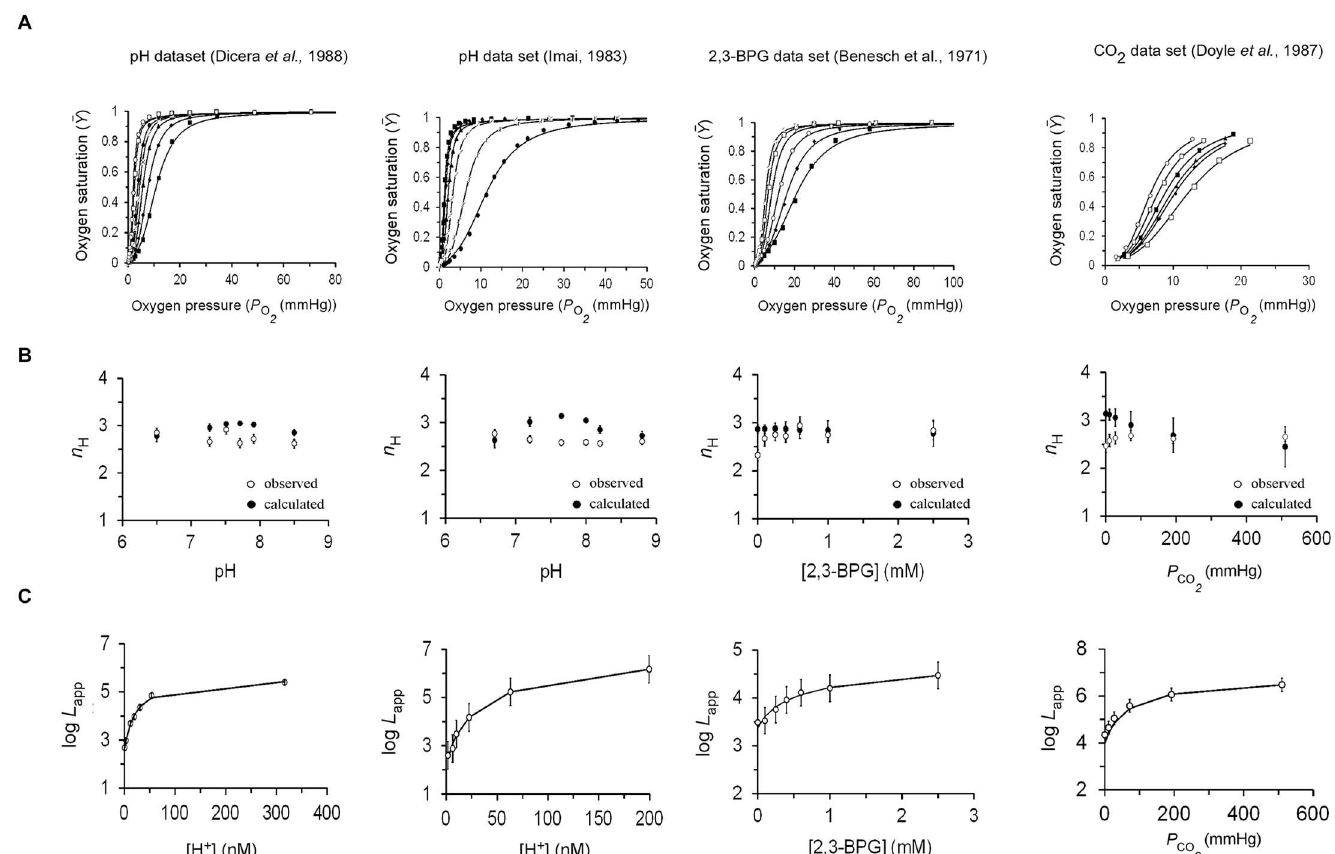
Fig 3. Successful application of global fitting analysis of hemoglobin physiological datasets. (A) Global fitting analysis of the human hemoglobinpH, CO 2 and 2,3-BPG physiological datasets using the traditional form of the MWC equation. Source data is indicated above each panel. (B) Dependence of observed (open circles) and calculated (filled circles) Hill values of each dataset on effector concentration. (C) Dependence of the apparent L values of each physiologicaldataset on effector concentration. Solid curves represent the results of curve fitting to the MWC-derived ¼ L ðð 1 þ ½ I (cid:138) = K T Þ = ð 1 þ ½ I (cid:138) = K R ÞÞ 4 , assuming non-exclusive binding of the inhibitor effector (I) to both the T and R MWC conformations equation L app o I I [11,12]. In the case of organophosphate inhibitors, a power of one was used in the above equation, as only one site is availableto BPG for binding to hemoglobin.